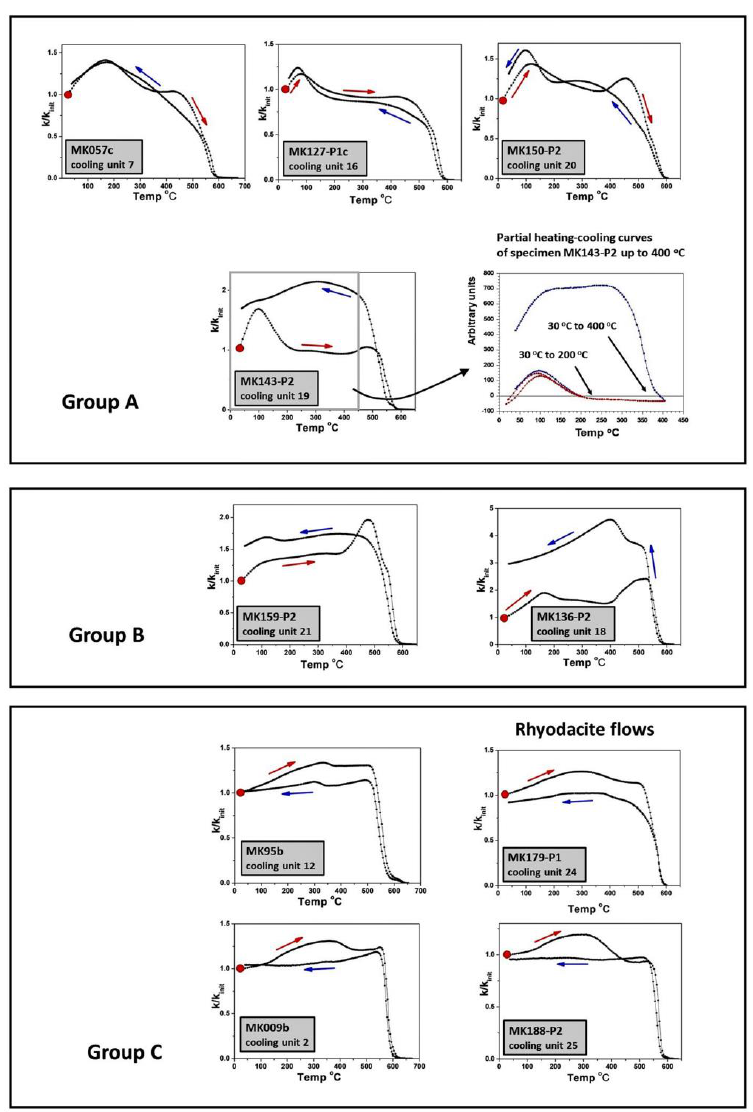
Figure 4. Thermo-magnetic k − T behavior of typical samples with MS normalized to initial susceptibility at room temperature. The red arrows indicate heating and the blue arrows show cooling cycles.